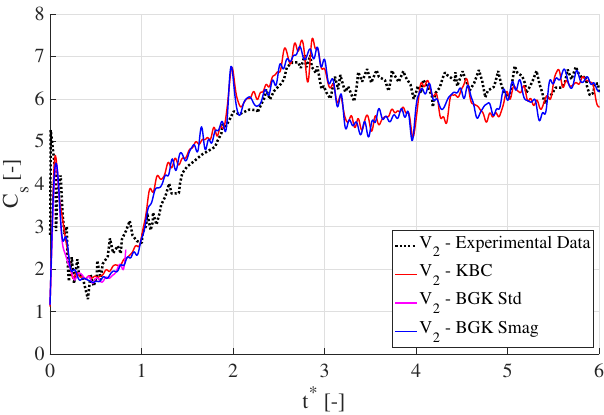
Figure 10. Comparison between experimental results presented by [32] and numerical model at Fr = 0.5772. Black dotted line represents experimental findings, solid red line the KBC results, magenta line the BGK without turbulence model, and the blue curve represents the BGK with Smagorinsky sub-grid